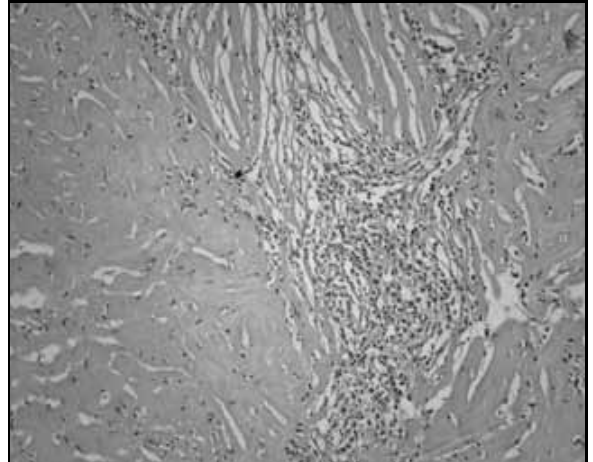
Figure 3 – Small lobules of meningothelial cells between dense areas of fibrosis (HE 100×) HE: hematoxylin-eosin.